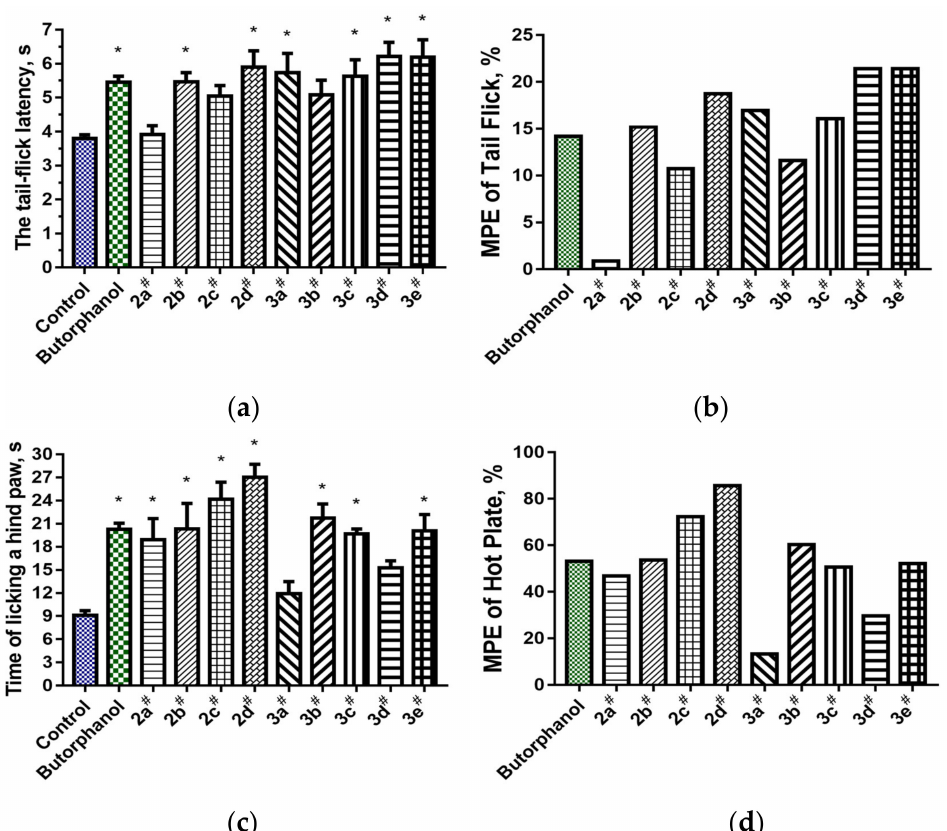
Figure 4. Analgesic activity in compounds 2 and 3 in Tail Flick and Hot Plate tests in comparison with butorphanol (1 mg/kg), mice, i.p. administration, M ± SEM; ( a ) tail-flick latency; ( b ) %MPE of tail-flick; ( c ) licking a hind paw latency; ( d ) %MPE of hot plate. Note: * Data are comparable to the control group ( p ≤ 0.05, one-way ANOVA, post-hoc Dunnett‘s test); # The dose is equimolar to butorphanol at a dose of 1